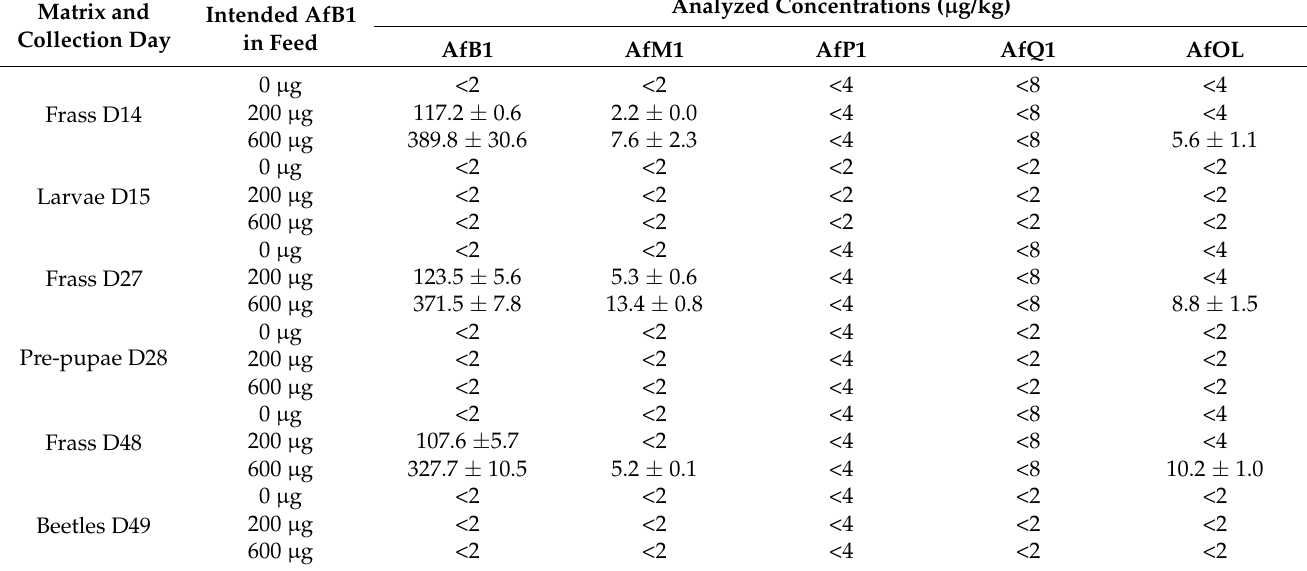
Table 2. Concentrations of aflatoxin B 1 (AfB 1 ) and metabolites aflatoxin M 1 (AfM 1 ), P 1 (AfP 1 ), Q 1 (AfQ 1 ) and aflatoxicol (AfOL) per matrix and day of collection, and treatment (concentration in feed). Concentrations in µ g/kg. Median and standard deviation, or limit of quantification (LOQ) value if all samples below this